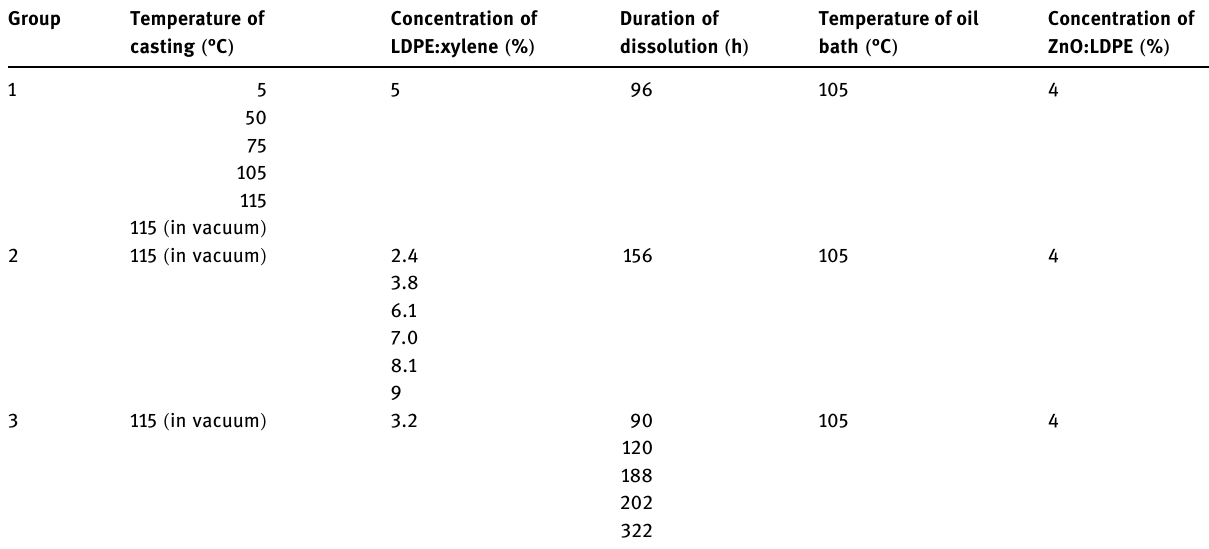
Table 1: Conditions for fi lm formation experiments Group Temperature of casting ( °C )